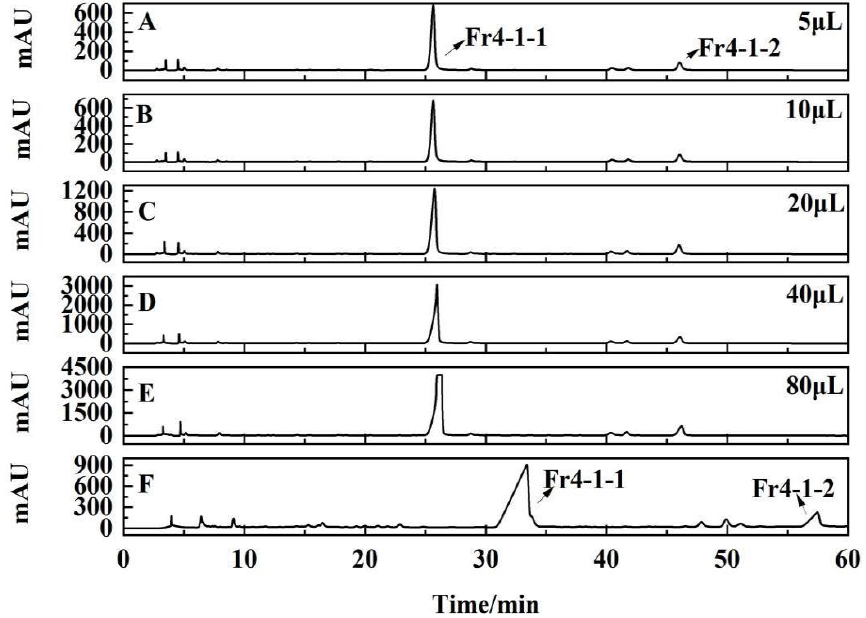
Figure 4. ( A – E ): HPLC analysis of Fr4-1 on Click XIon analytical column; ( F ): preparation chromatograms of Fr4-1 on the Click XIon preparation column.